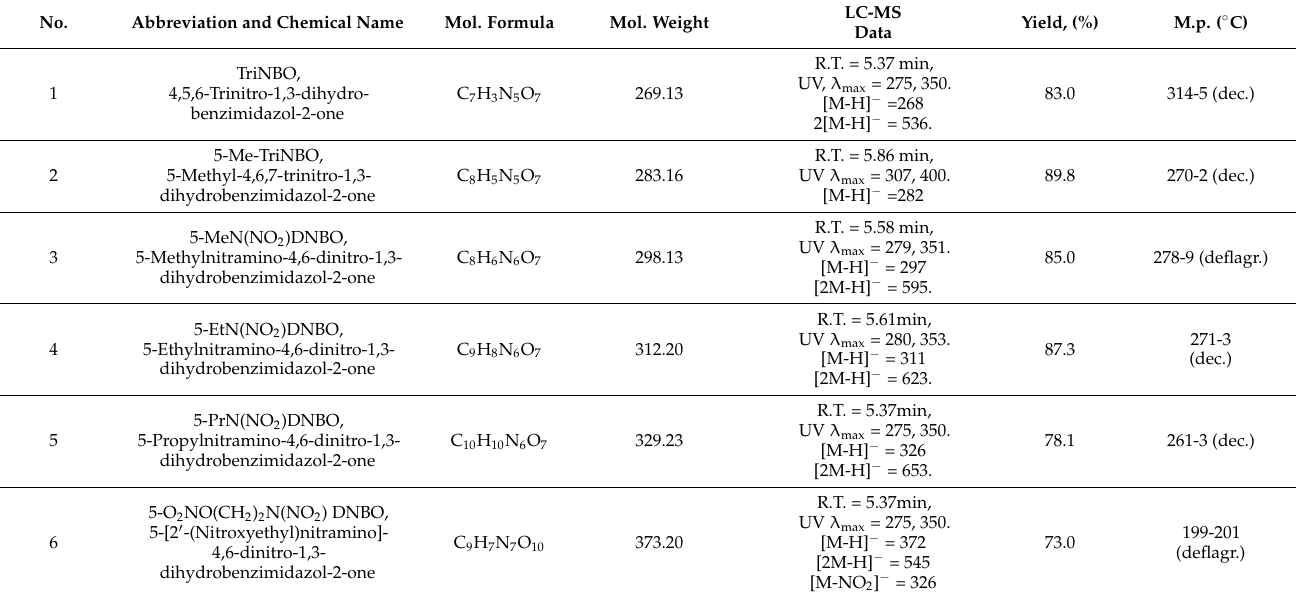
Table 3. The main data of the synthesized 1,3-dihydro- 2H -benzimidazol-2-one nitro- and nitramino compounds.